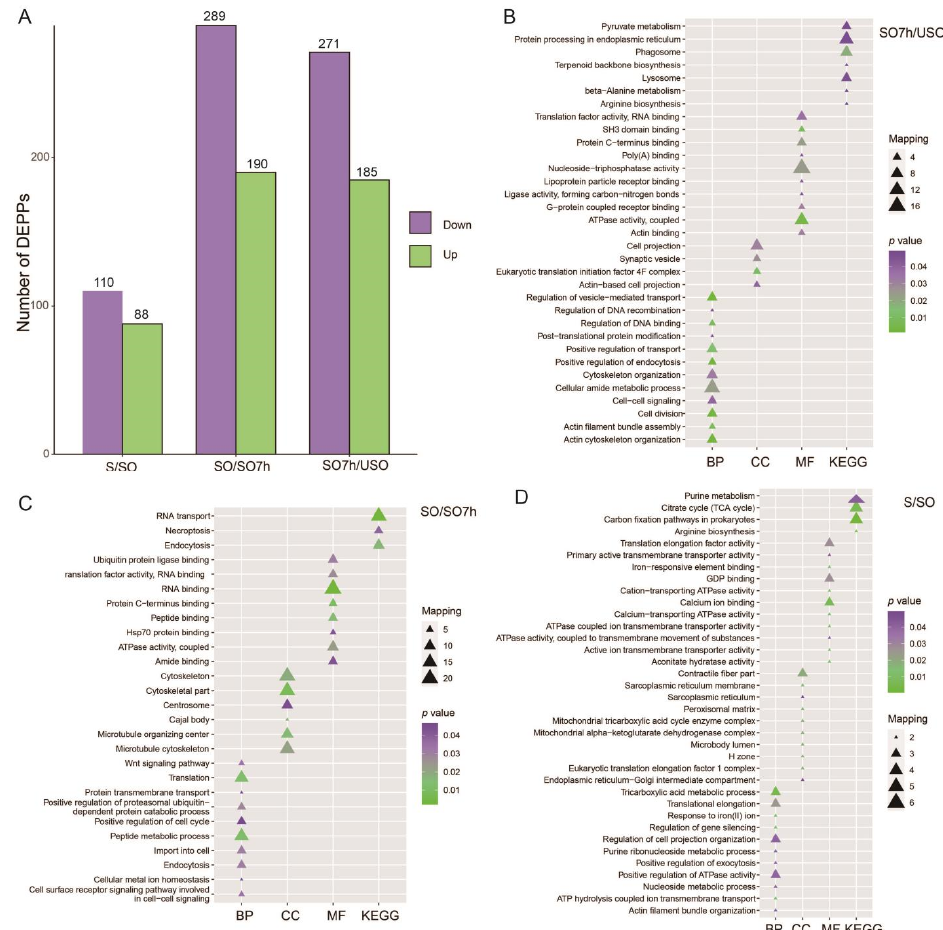
Figure 2. ( A ) The number of DEPPs in each comparison. ( B ) Functional enrichment analysis results for DEPPs in SO7h vs. USO. ( C ) Functional enrichment analysis results for DEPPs in SO vs. SO7h. (D) Functional enrichment analysis results for DEPPs in S vs. SO.